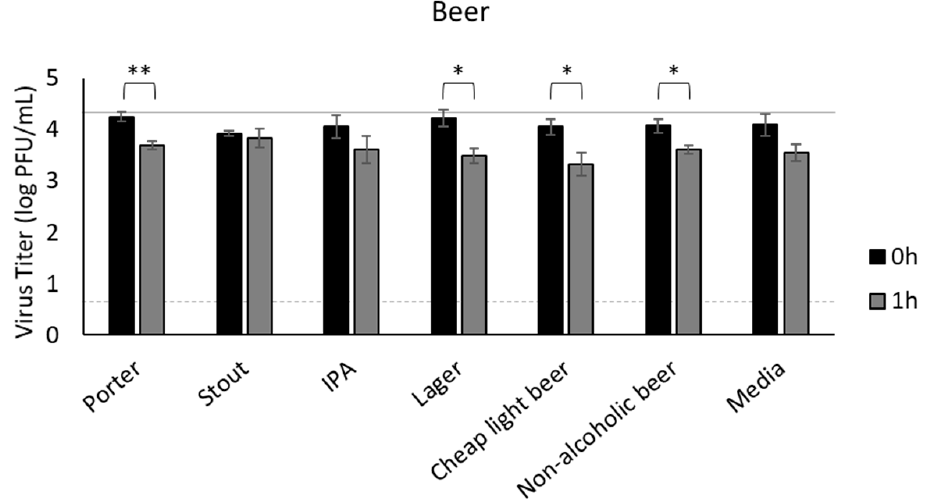
Figure 3. Survival of SARS-CoV-2 in beer. SARS-CoV-2 was recovered from beverages immediately after inoculation (0 h) and 1 h later, quantified by plaque assay on Vero E6 cells, and shown as log PFU/mL. The inoculum is shown as a solid gray line (4.3 log PFU/mL) and the detection limit of the plaque assay is shown as a dashed line (0.7 log PFU/mL). Significant differences between means at 0 h and 1 h are shown by brackets and asterisks (* <0.05; ** <0.01). Error bars = SEM.